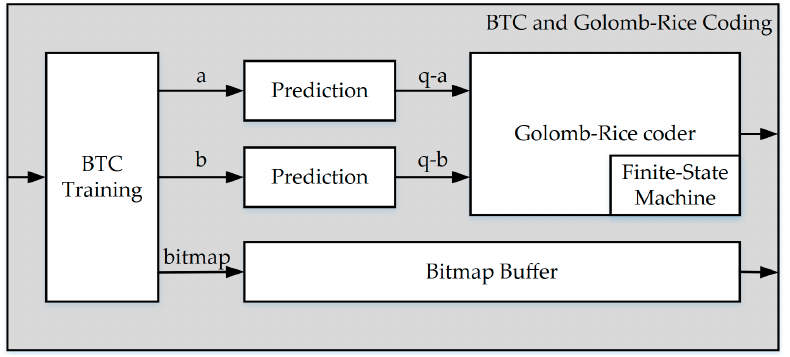
Figure 8. The block diagram of BTC and Golomb–Rice coding.